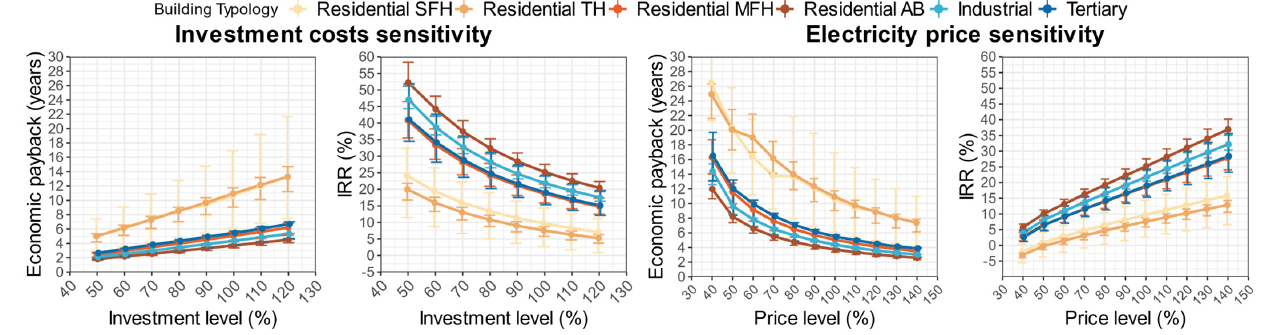
Figure 11. Sensitivity of the main PVSC variables as a function of investment CL and PL with respect to the NB base scenario for the selected sample of buildings.